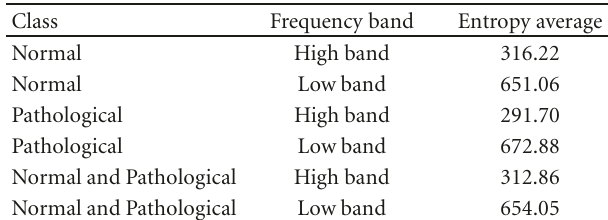
Table 2: Average